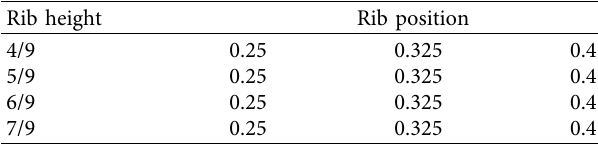
Figure 2: Schematic diagram of nonpremixed micro column burners: (a) without annular rectangular ribs and (b) with annular rectangular ribs. Table 1: Dimensionless rib height and rib position. Table 2: Chemical reaction mechanism of H/air combustion.